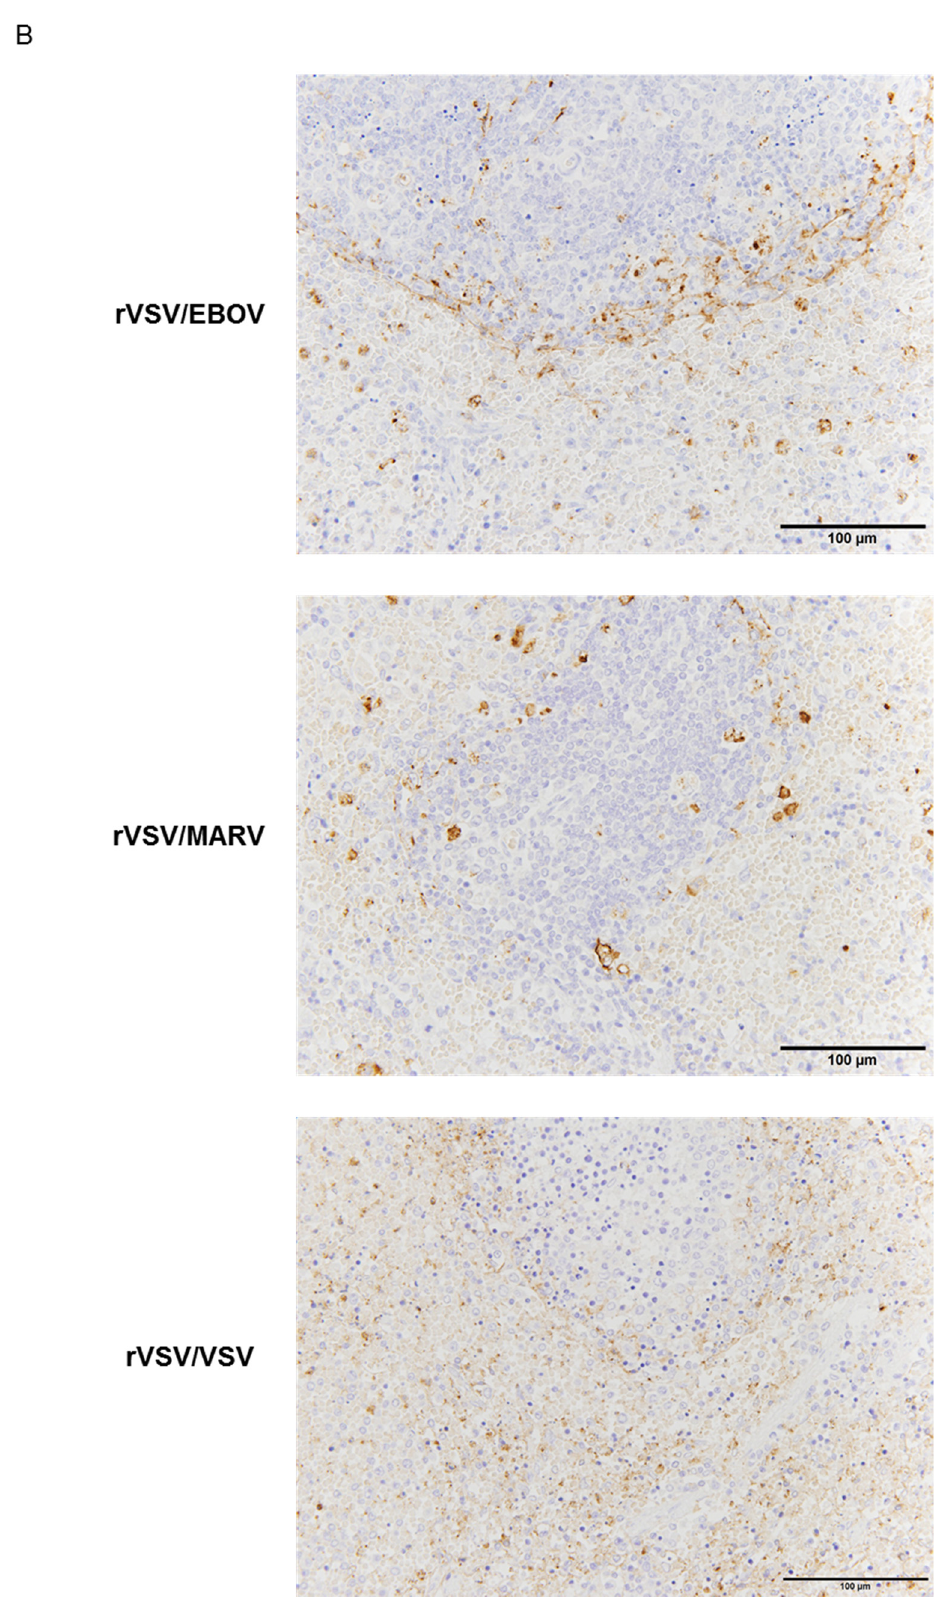
Figure 4. Histological and immunohistochemical analyses of liver, spleen, and brain (cerebral cortex). ( A ) Tissue sections were stained with hematoxylin and eosin (HE) and a rabbit anti-VSV N polyclonal antibody. ( B ) Enlarged images of the spleen sections stained with the anti-VSV N antibody are also shown. Scale bars represent 100 µ m. Brown-stained cells represent viral antigen-positive cells.